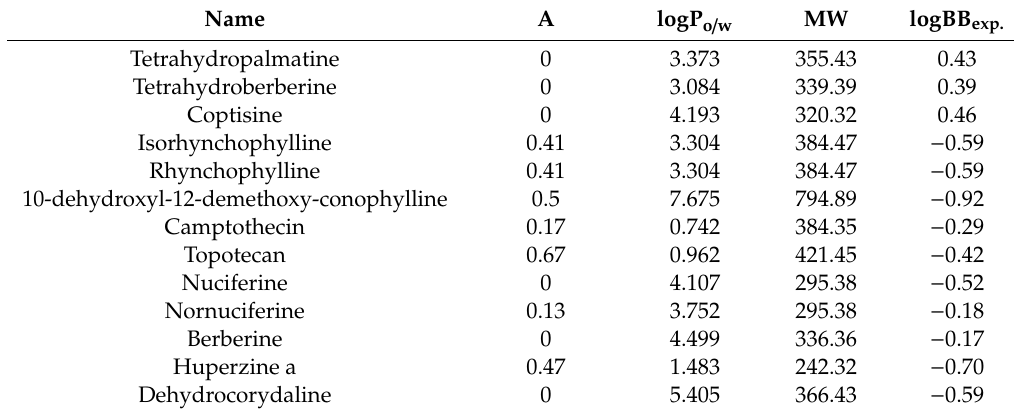
Table 1. Physicochemical parameters (ACD / Percepta software) and the experimentally obtained logBB values (logBB exp ) [30–37].